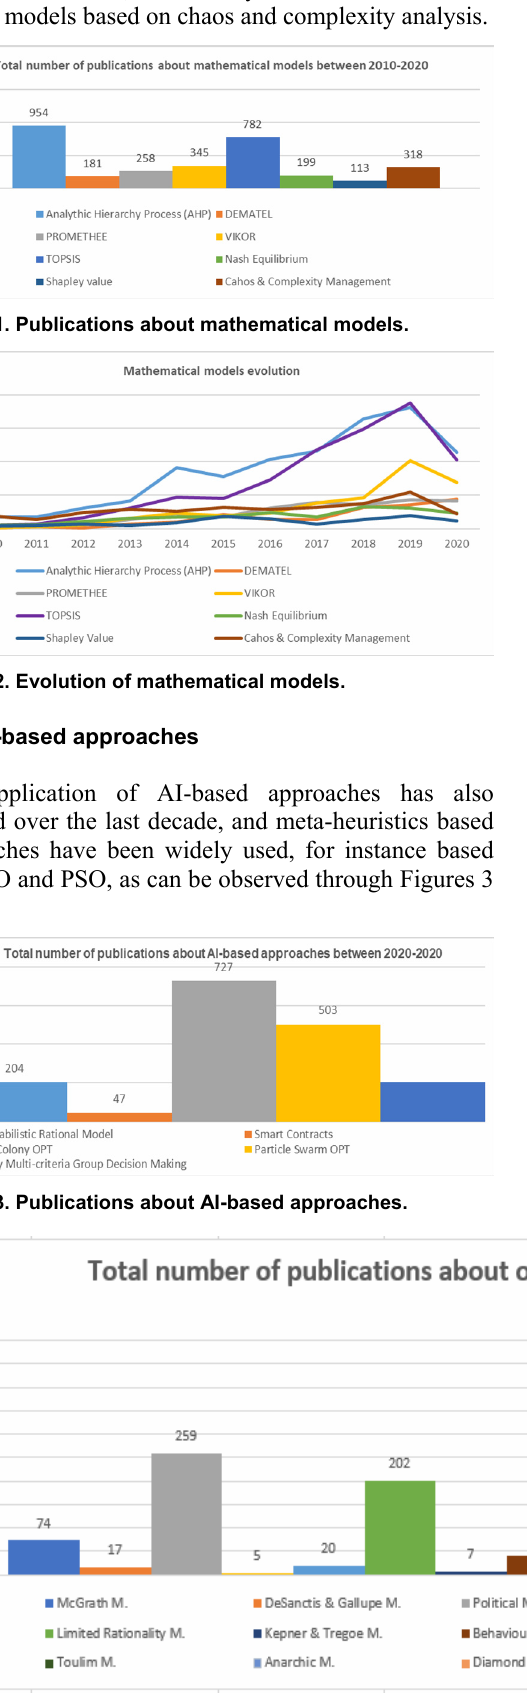
Figure 5. Publications about other